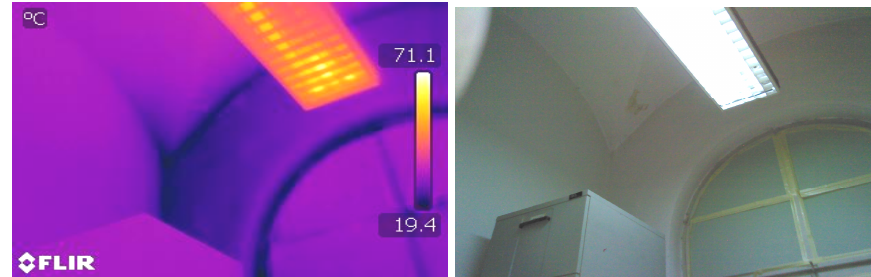
Figure 11 – Poor thermal insulation in the photo collections depot.